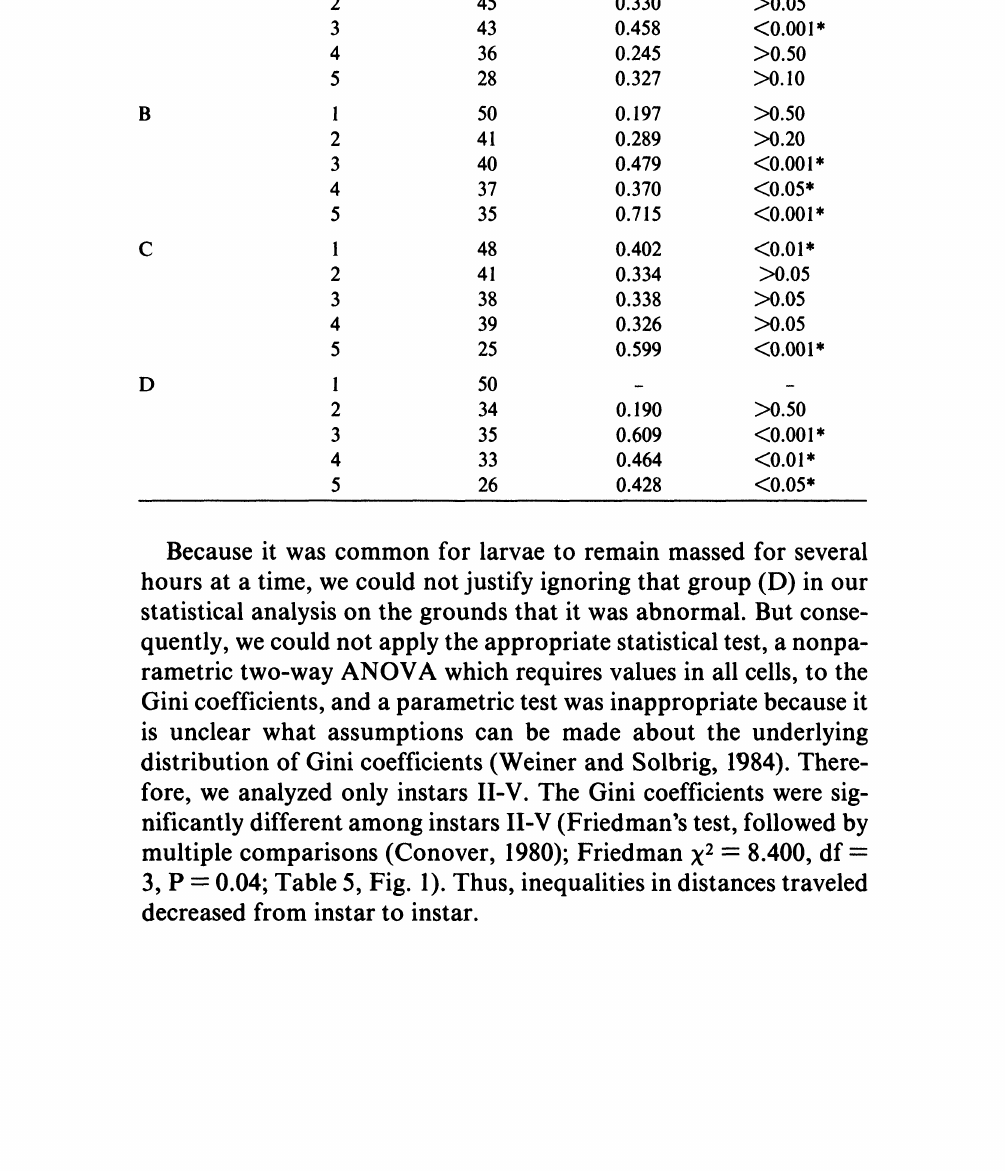
Table 2. Comparison of distance traveled among 5 trials, with n number of larvae, W Kendall’s coefficient of concordance, and significance (P) < 0.05 indi- cated by *. The null hypothesis for the Kendall test was W 0 when distances varied randomly from trial to trial. Thus, a significantly high value indicates that distances traveled by individuals were consistent from trial to trial. Group Instar n W P 50 0.307 >0.10 2 45 0.330 >0.05 3 0.458 <0.001" 4